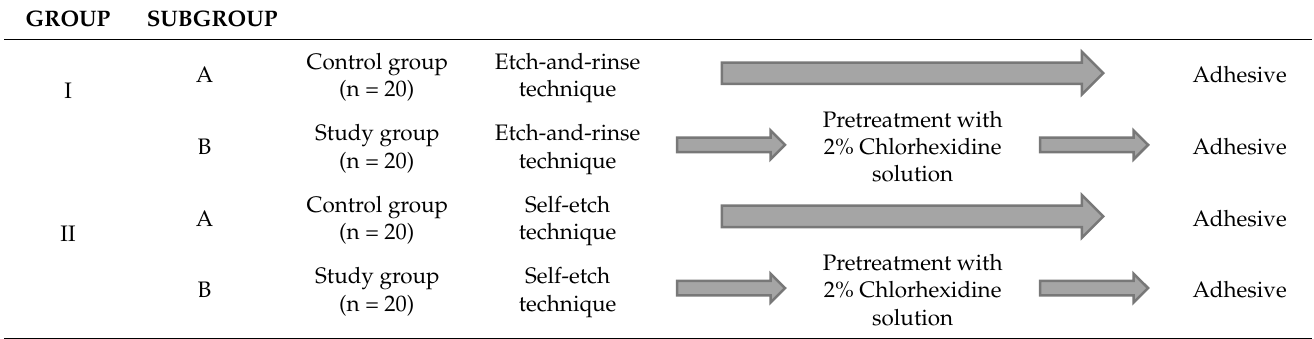
Table 2. Study groups.